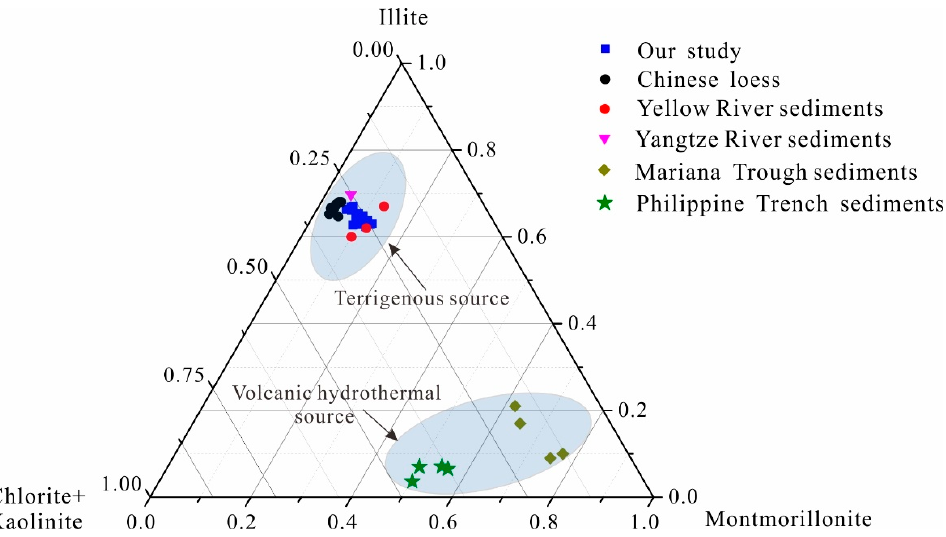
Figure 4. Ternary showing variation in clay mineral compositions of sediments for GC1601 and other geological regions. Chinese loess data are from [37], Yellow River sediments data are from [38–40], Yangtze River sediments data are from [41], Mariana Trough sediments data are from [42], Philippine Trench sediments data are from [43,44].